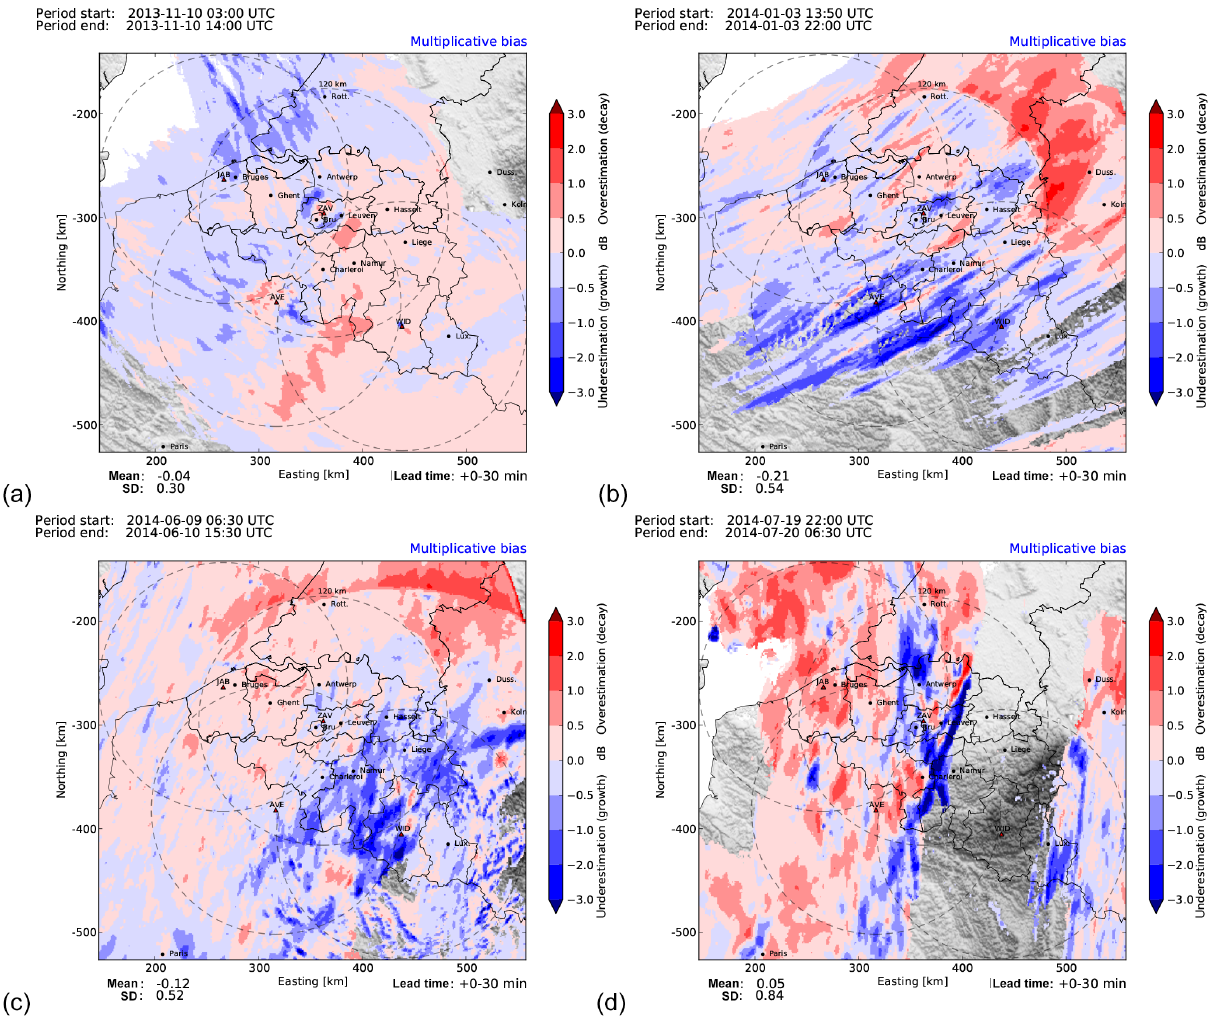
Figure 4. Average 0–30min multiplicative forecast biases for the Ghent cases on (a) 10 November 2013 and on (b) 3 January 2014 and the Leuven cases on (c) 9–10 June 2014 and on (d) 19–20 July 2014. The interpretation of under- and over-estimations by STEPS as systematic rainfall growth and decay or simply as radar measurement biases is subject to interpretation as explained in the